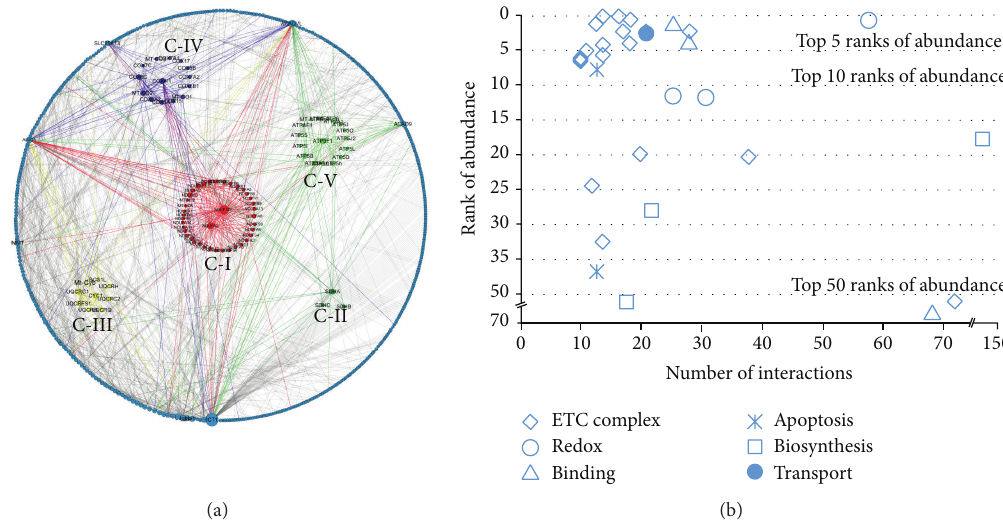
Figure 7: (a) The quantitative analysis of mitochondrial interactome. Each node represents a protein, the size of each mitochondrial node represents the number of connections in the protein-protein interaction network, and the larger nodes represent more interactions. (b) The analysisoftop30proteinsinmitochondrialinteractome.Differenttypesrepresentdifferentfunctions, 𝑥 -axisrepresentsnumberofinteraction, 𝑦 -axis represents rank of abundance, 17 of them are from ETC complex, and almost all proteins are top 50 high abundance and, especially, 18 proteins are top 10 high